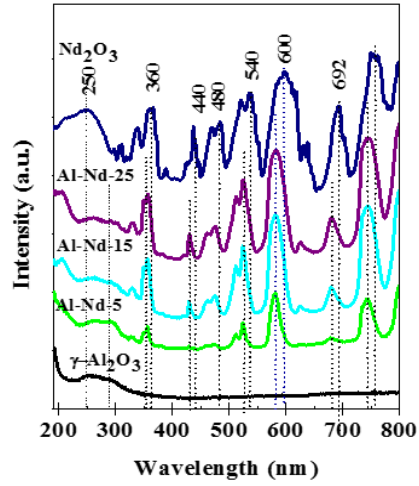
Figure 7. UV-Vis spectra of γ -Al 2 O 3, Al-Nd- x binary oxides and Nd 2 O 3 .